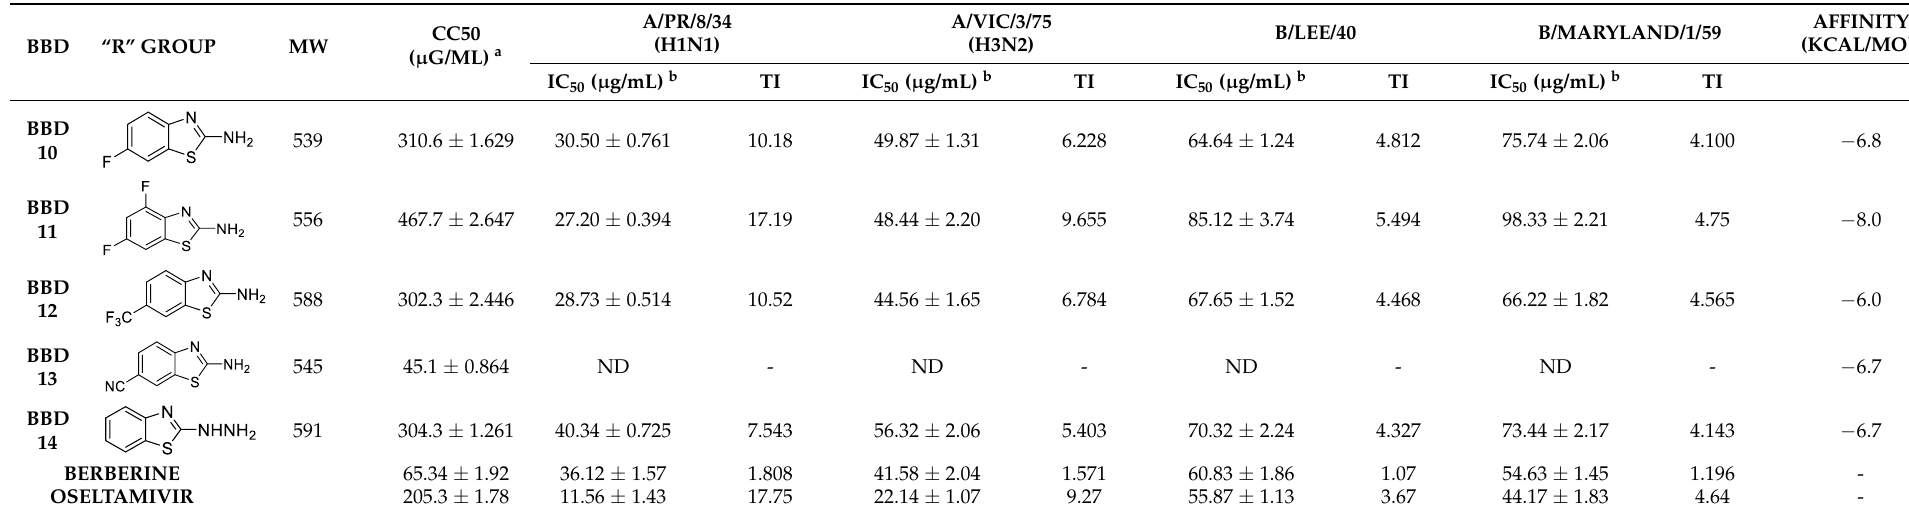
a CC b IC a CC 50 : Concentration of the BBDs in μg/mL inhibiting 50% of virus-induced cytopathic effects. b IC 50 : The cytotoxic con- 50 : Concentration of the BBDs in µ g/mL inhibiting 50% of virus-induced cytopathic effects. 50 : The cytotoxic concentration of 50% on normal cells (MDCK) in µ g/mL. ND; Not detected. The results are a CC 50 : Concentration of the BBDs in μg/mL inhibiting 50% of virus-induced cytopathic effects. b IC 50 : The cytotoxic con- a CC 50 : Concentration of the BBDs in μg/mL inhibiting 50% of virus-induced cytopathic effects. b IC 50 : The cytotoxic con- the mean of standard deviation ( ± S.D) in triplicate. TI: Therapeutic index (TI = CC 50 /IC 50 a CC 50 : Concentration of the BBDs in μg/mL inhibiting 50% of virus-induced cytopathic effects. b IC 50 : The cytotoxic con- centration of 50% on normal cells (MDCK) in μg/mL. ND; Not detected. The results are the mean of standard deviation centration of 50% on normal cells (MDCK) in μg/mL. ND; Not detected. The results are the mean of standard deviation centration of 50% on normal cells (MDCK) in μg/mL. ND; Not detected. The results are the mean of standard deviation centration of 50% on normal cells (MDCK) in μg/mL. ND; Not detected. The results are the mean of standard deviation (±S.D) in triplicate. TI: Therapeutic index (TI = CC 50 /IC 50 ). (±S.D) in triplicate. TI: Therapeutic index (TI = CC 50 /IC 50 ). (±S.D) in triplicate. TI: Therapeutic index (TI = CC 50 /IC 50 ). (±S.D) in triplicate. TI: Therapeutic index (TI = CC 50 /IC 50 ).